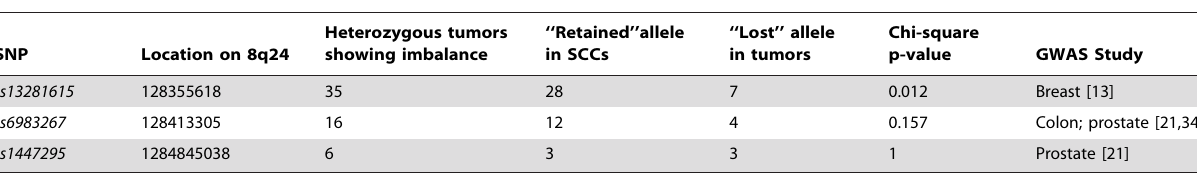
Table 3. 8q24 variants tested for preferential allelic